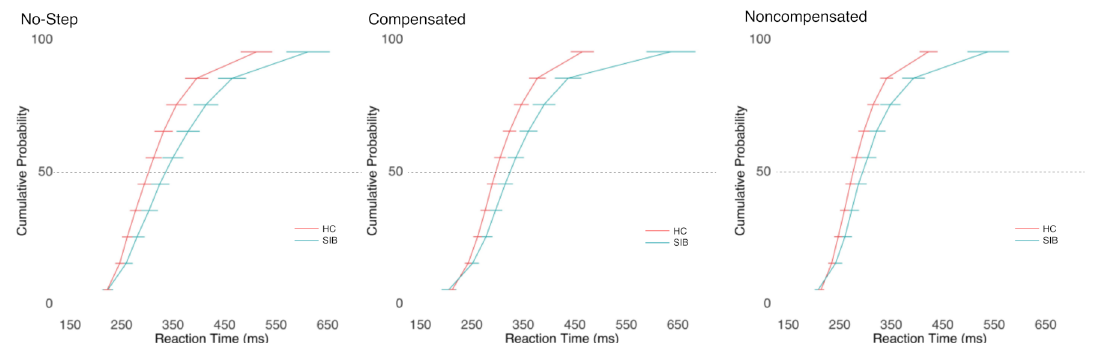
Figure 4. Vincentized RT distributions for no-step trials ( left panel ), compensated trials (relative to T2 onset; ( middle panel )), and noncompensated trials ( right panel ) for experiment 2. The reaction times for each participant were binned into deciles split by trial type in order to visualize the distributions, which complimented the ANOVAs examining the mean reaction times reported in the main text. Decile means were averaged across participants for each group (HC and SIB). Each error bar shows the standard error of each decile